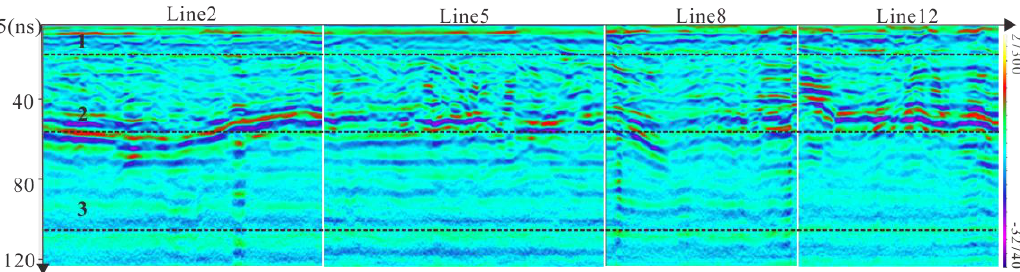
Figure 6. Amplitude of ground penetrating radar (GPR) data: the black dashed lines 1, 2, and 3 respectively notes 20 ns, 50 ns and 100 ns.